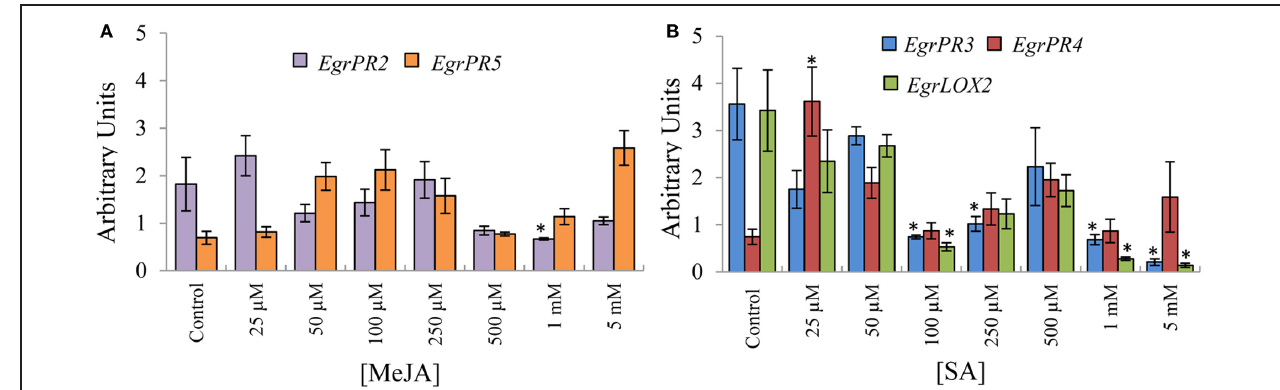
FIGURE 2 | Relative transcript abundance of the putative orthologs for the EgrPR defence genes in tissue treated with the opposite phytohormone. The y-axis represents the relative expression ratios expressed in arbitrary units. Putative SA signature defence genes (A) were normalized with EguIDH and EgrARF whereas the putative MeJA signature